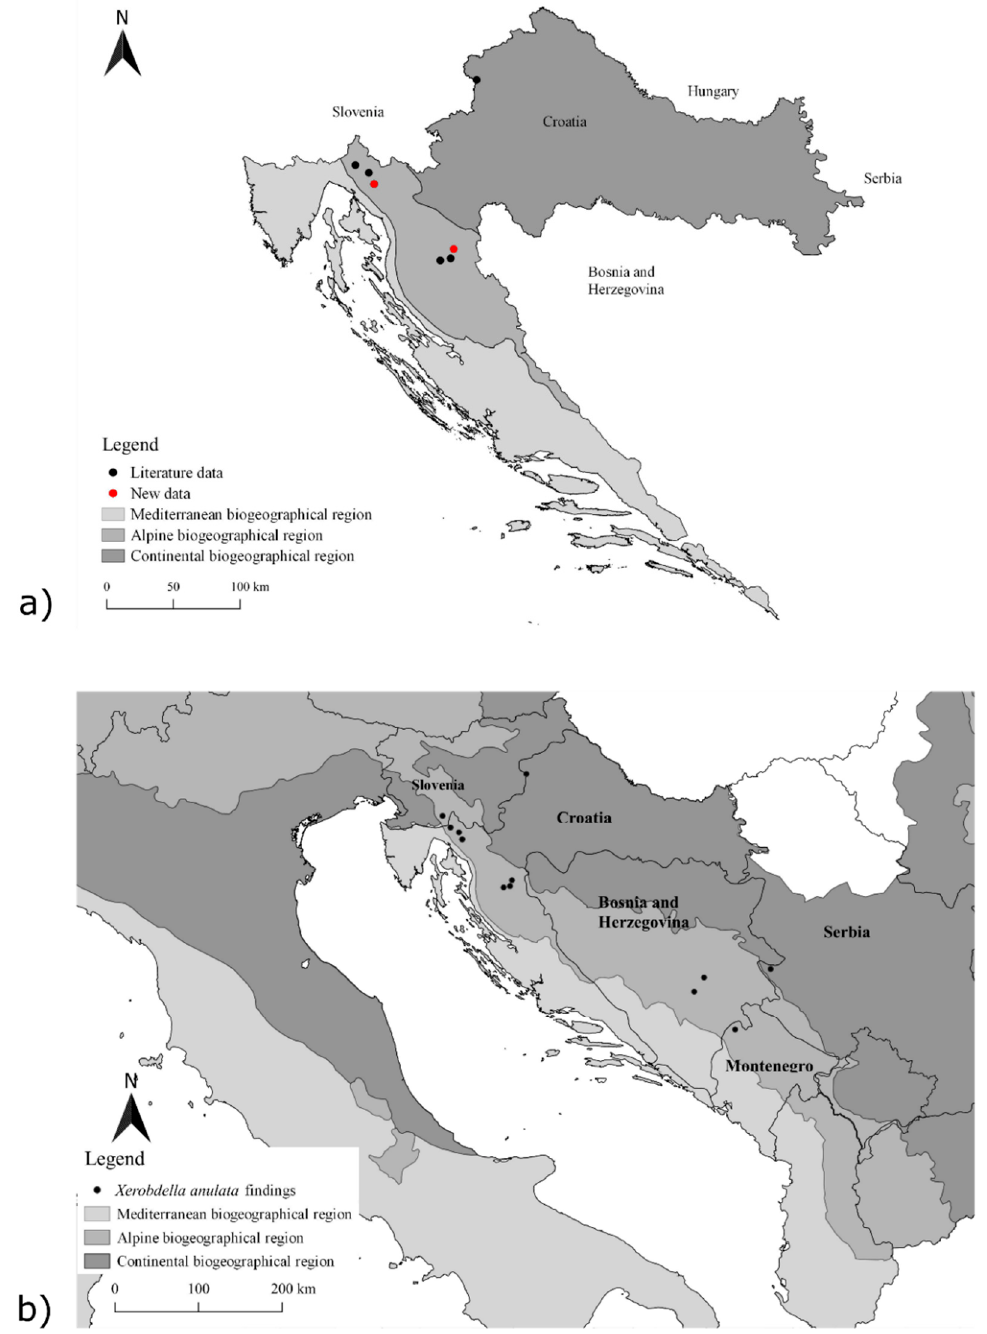
Figure 2. ( a ) Distribution of the Dinaric land leech ( Xerobdella anulata ) in Croatia, based on the historic literature data and new findings; ( b ) currently known distribution of the Dinaric land leech ( X. anulata ) in Europe, with respect to biogeographical regions.